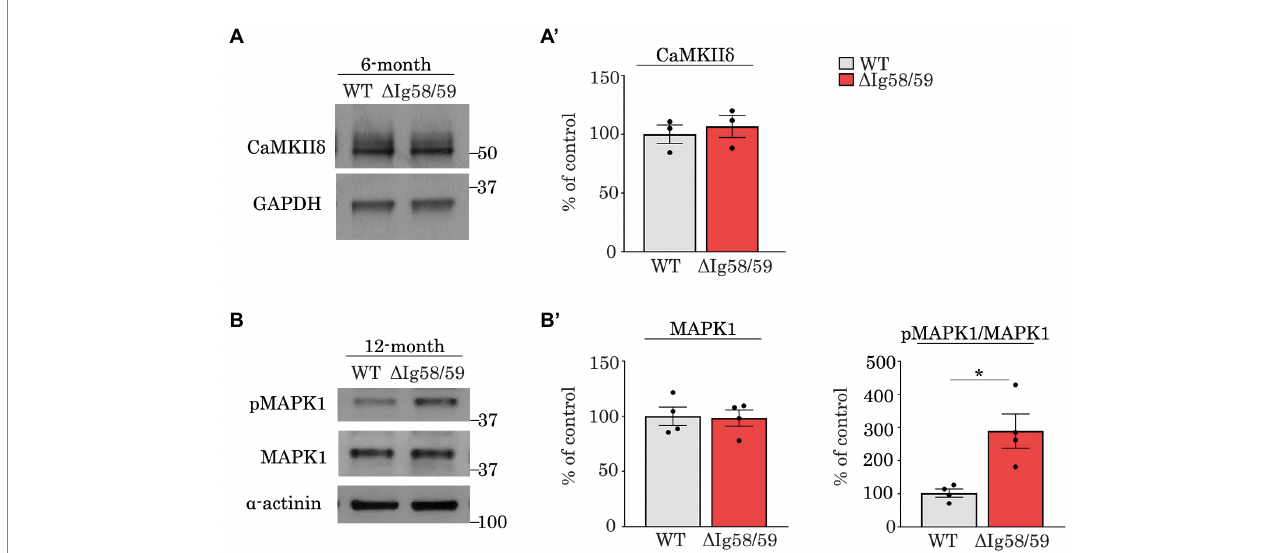
FIGURE 8 Immunoblot analysis confirmed up-regulation of phosphorylated MAPK1 in 12-month old Obscn- Δ Ig58/59 atria. (A,A’) Representative immunoblots (A) and relative quantifications (A’) did not reveal statistically significant alterations in the expression of CaMKII δ in lysates prepared from 6-month-old wild-type and Obscn- Δ Ig5859 atria; t -test, p = 0.62. (B,B’) Representative immunoblots (B) and relative quantifications (B’) revealed an up-regulation of phosphorylated MAPK1 (also known as ERK2) at its canonical activation motif, pThr183/Tyr185, in Obscn- Δ Ig5859 atria at 12-months but no differences